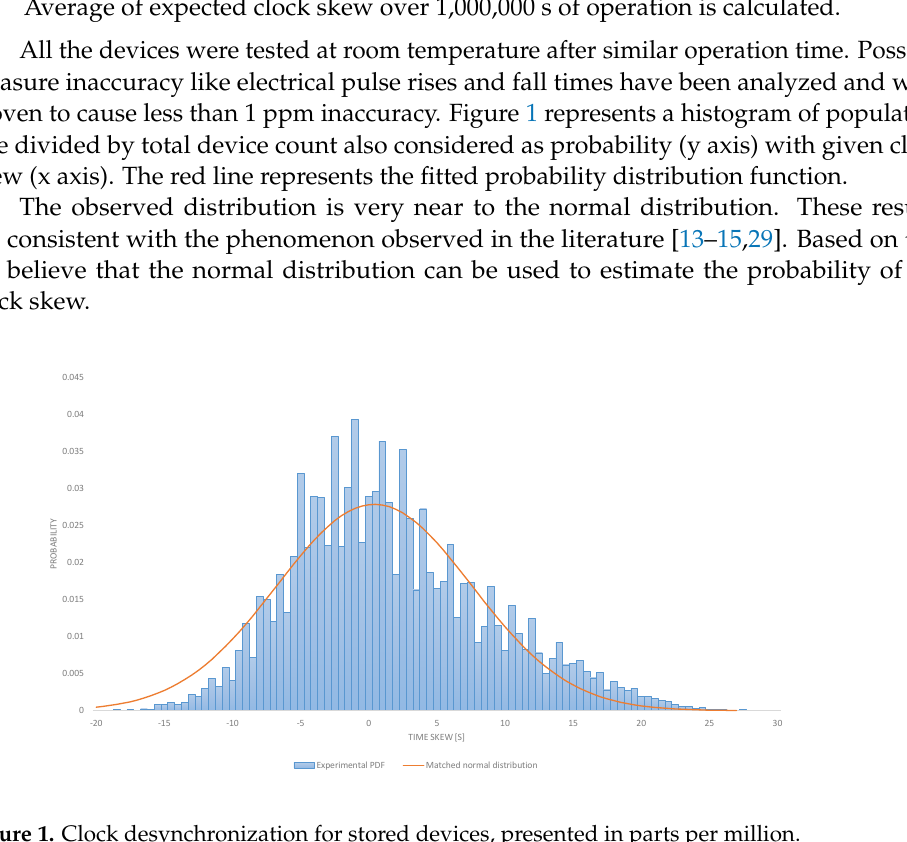
Figure 1. Clock desynchronization for stored devices, presented in parts per